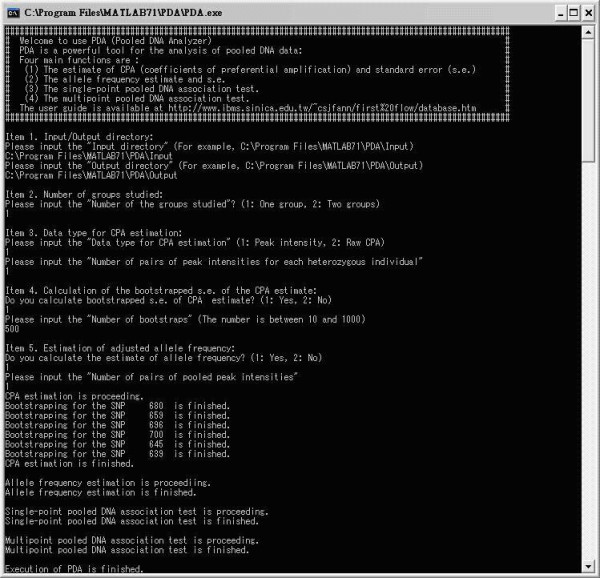
Interface of the execution of PDA on machines without MATLAB® installed.